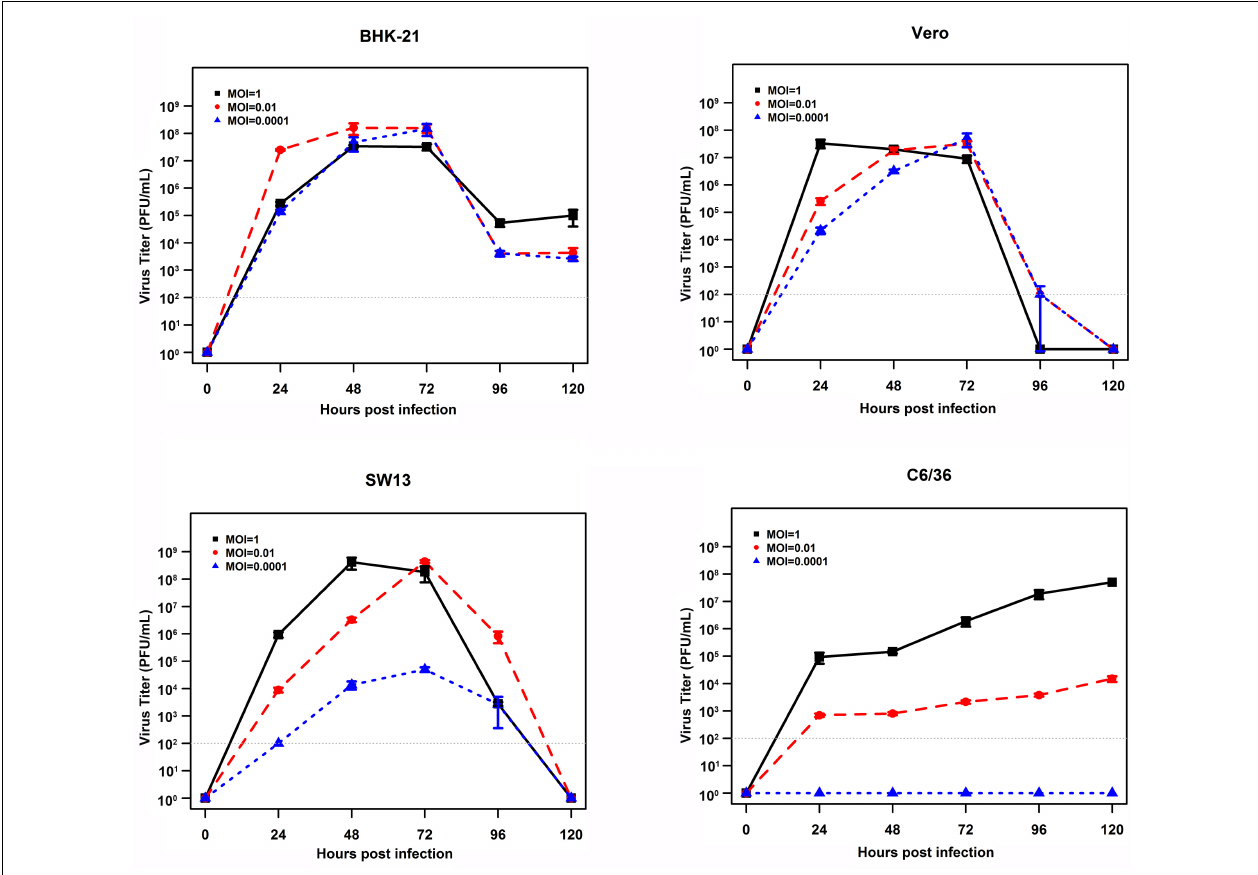
FIGURE 4 | Growth curves of EBIV (MOI = 1, 0.01, and 0.0001) in cells derived from mammals and mosquitoes. A significant difference in the highest virus titers was only observed between C6/36 and BHK cells (C6/36 vs. BHK with P < 0.01, SW13 vs. BHK with P = 0.02, Vero vs. BHK with P = 0.03, SW13 vs. Vero with P = 0.99, C6/36 vs. SW13 with P = 0.66, and C6/36 vs. Vero with P =